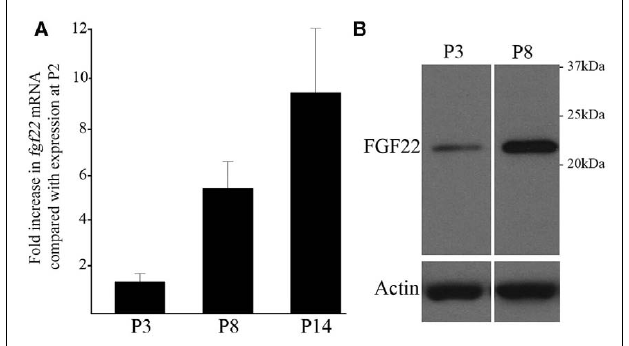
FIGURE 3 | Increases in fgf22 mRNA and FGF22 protein levels in dLGN coincide with the maturation of retinal terminals. (A) The developmental up-regulation of fgf22 mRNA from P2 to P14 in dLGN was examined by quantitative RT-PCR (qPCR). Data from P3, P8, and P14 were compared against that at P2. All data was normalized to actin mRNA levels. Data are shown ± SEM; n > 4. (B) Western blots demonstrate an increase in FGF22 protein from P3 to P8 in dLGN protein extracts. Levels of actin were used as loading controls.